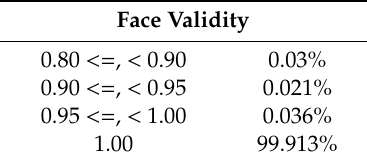
Table 3. Mesh validation diagnostic